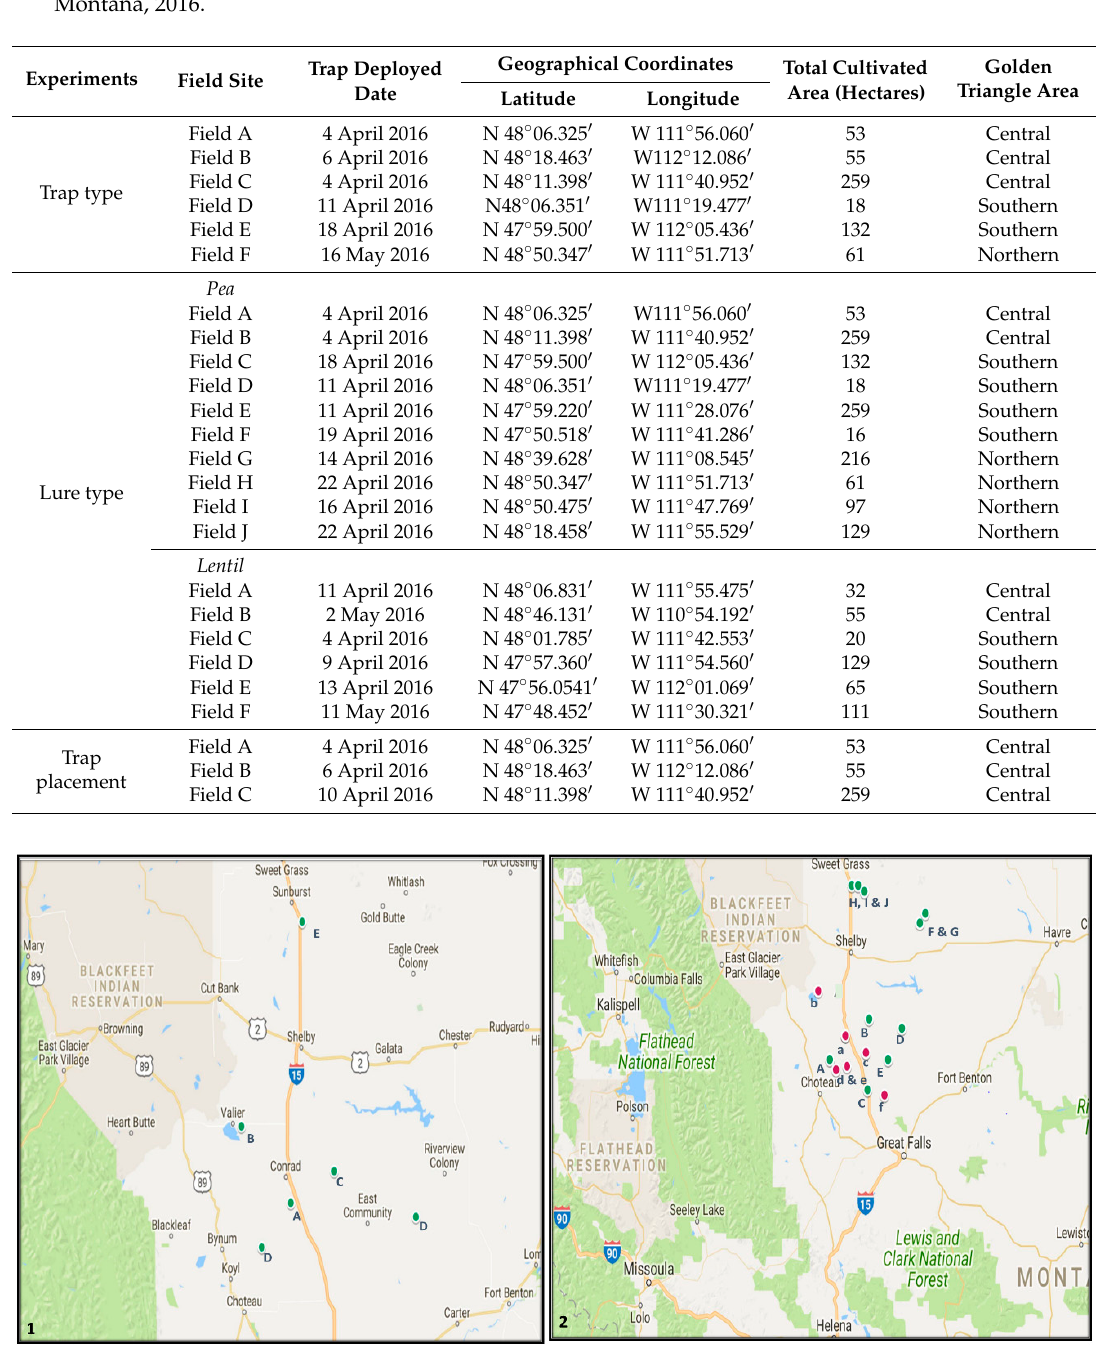
Figure 1. Montana State showing field sites: ( 1 ) trap type and placement and ( 2 ) lure type. Green and pink circles indicate field pea and lentil fields, respectively.